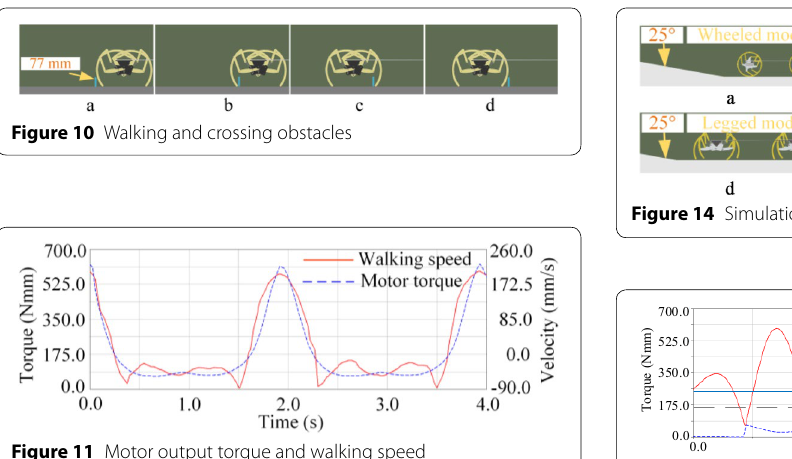
Figure 11 Motor output torque and walking speed